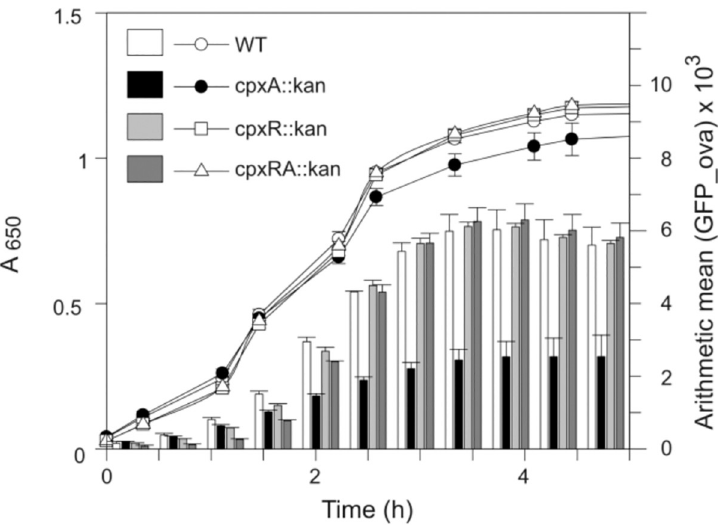
Fig 1. CpxR activity is responsible for hilA transcription. Fluorescence was determined for the SL1344 wild type (white symbols), cpxA (black symbols), cpxR (silver symbols) or cpxRA (dark gray symbols) strains transformed with a plasmid carrying a GFP fusion to the hilA promoter (pD.2E) [52]. Shown are the growth curves (circles) and expression results (bares) for cultures grown under invasion inducing conditions. Shown are the means ± S.E.M. of biological triplicates